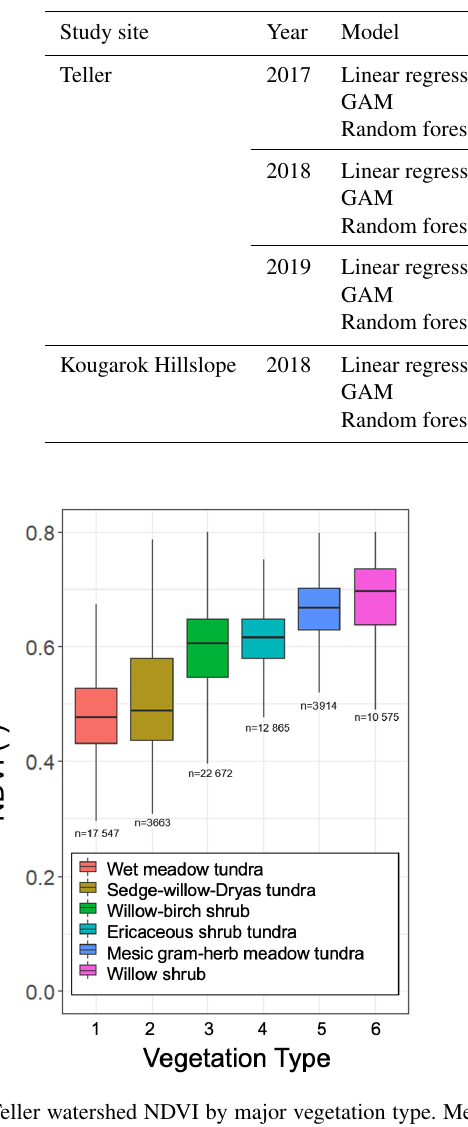
Figure 5. Teller watershed NDVI by major vegetation type. Mesic gram–herb is short for mesic graminoid–herbaceous tundra. Ta- ble A1 details each vegetation type.